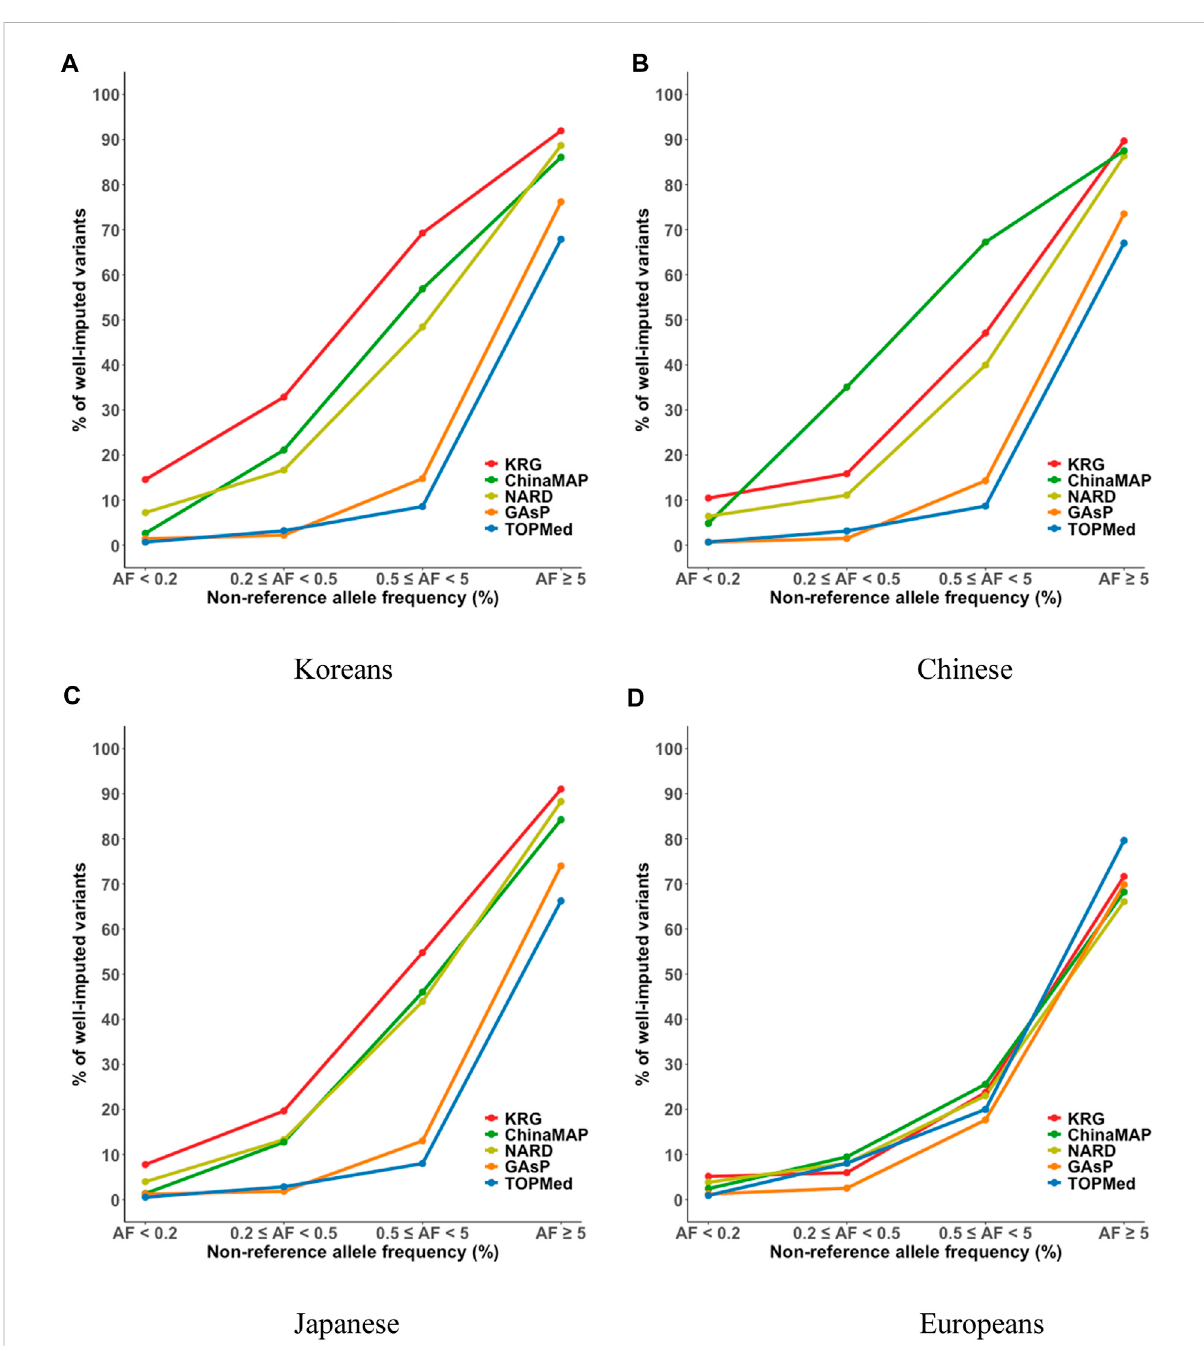
FIGURE 4 Percentofwell-imputedvariants,determinedbycombiningreferenceandgenotypepanelsmimickingtheKBA.The%ofwell-imputedvariants (estimated r 2 ≥ 0.8) was computed for the (A) Korean, (B) Chinese, (C) Japanese, and (D) European populations. The x -axes indicate the frequencies of non-reference alleles. The y -axes represent the % of well-imputed variants among the imputed results. Abbreviations: KBA, Korea Biobank